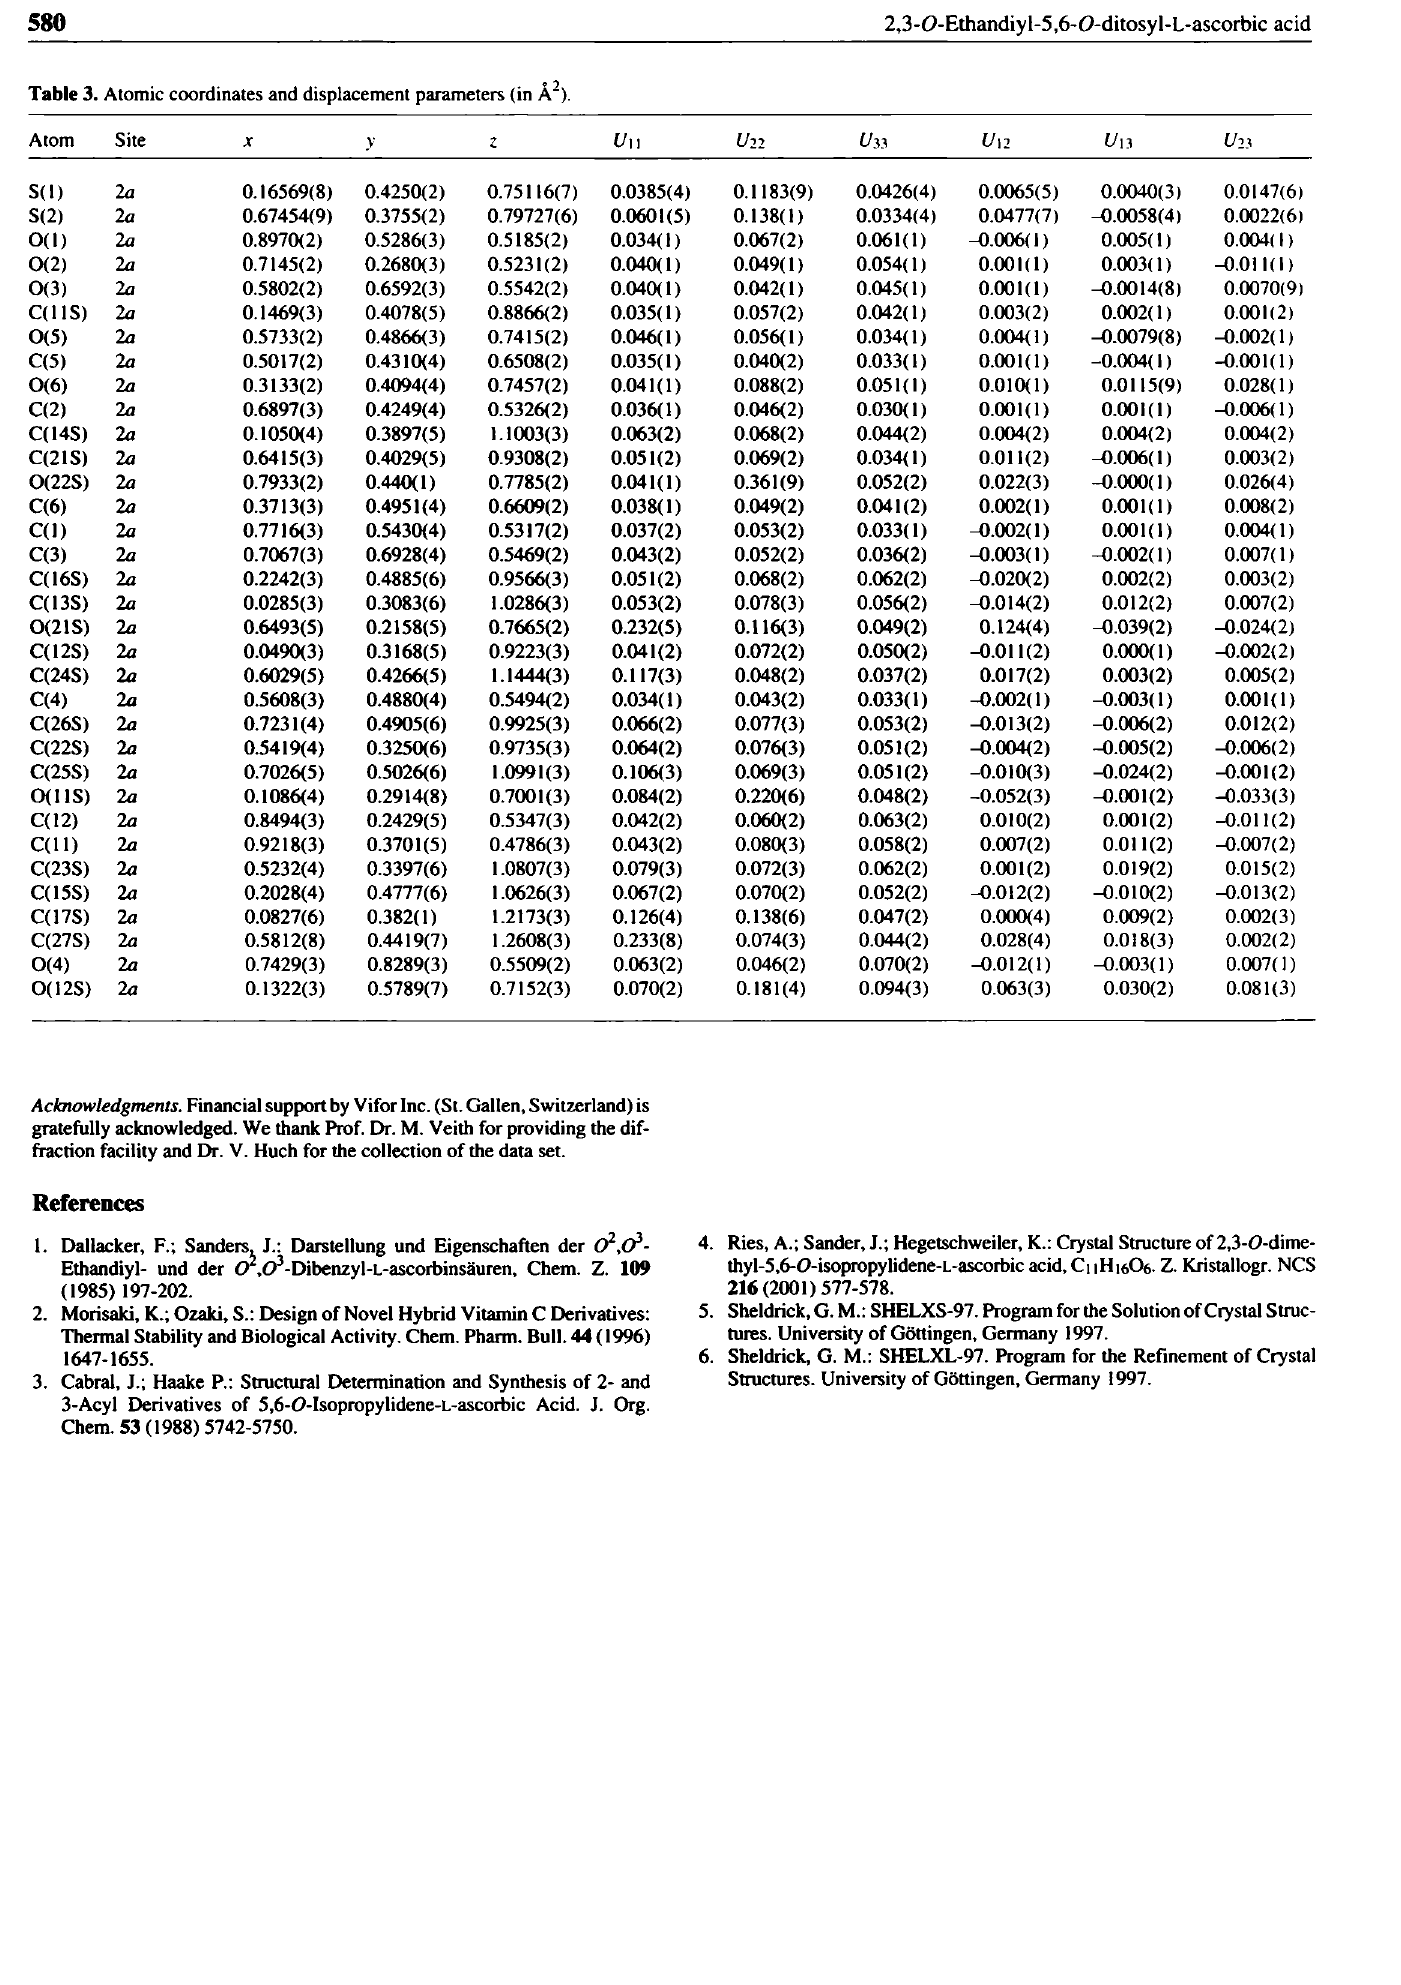
Table 3. Atomic coordinates and displacement parameters (in A 2 ). Atom